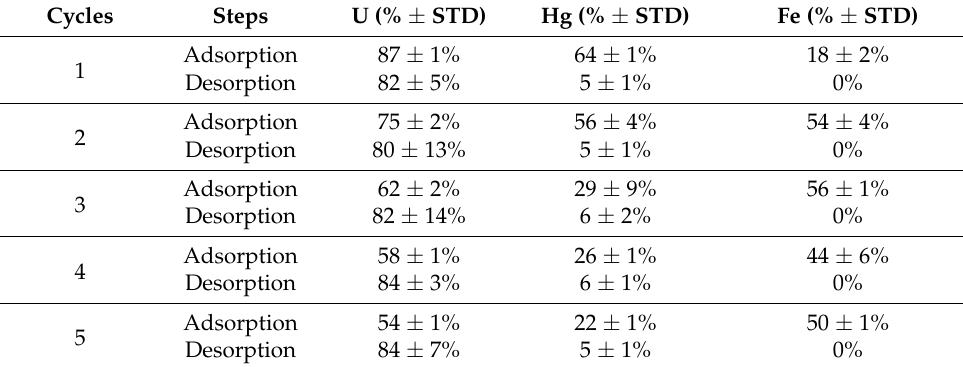
Table 6. Extraction and desorption of U, Hg, and Fe on chelating resin Lewatit TP260 through multiple cycles in triplicate (mean and standard